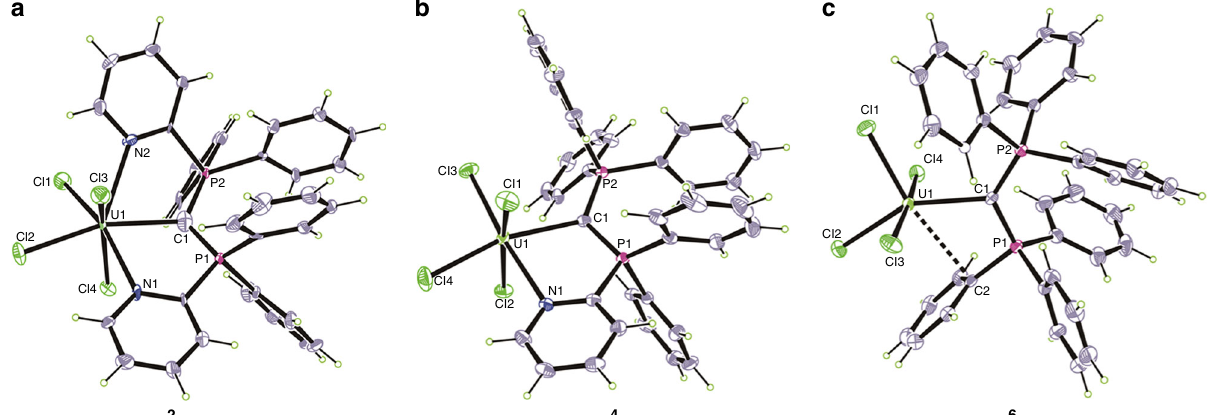
Fig. 2 Molecular structures of CDP-UCl 4 adducts 2 , 4 , and 6 . a – c Solid-state structures of 2 ( a ), 4 ( b ), and 6 ( c ) by X-ray crystallography with 50% probability ellipsoids. Solvent molecules are omitted for clarity. Selected experimental [calculated] bond distances (Å) and angles (deg) for 2 : U1 – C1